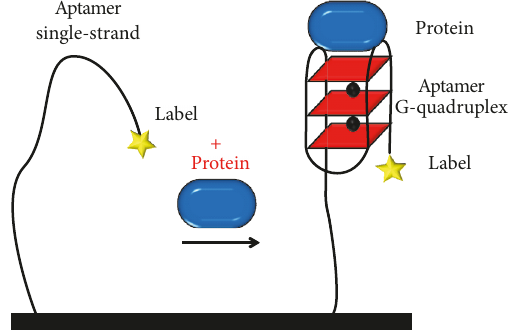
Scheme 5: Folding-based GQ electrochemical biosensor for the detection of